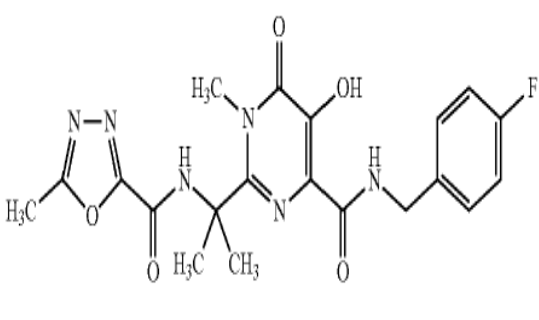
Figure 1. Chemical structure of